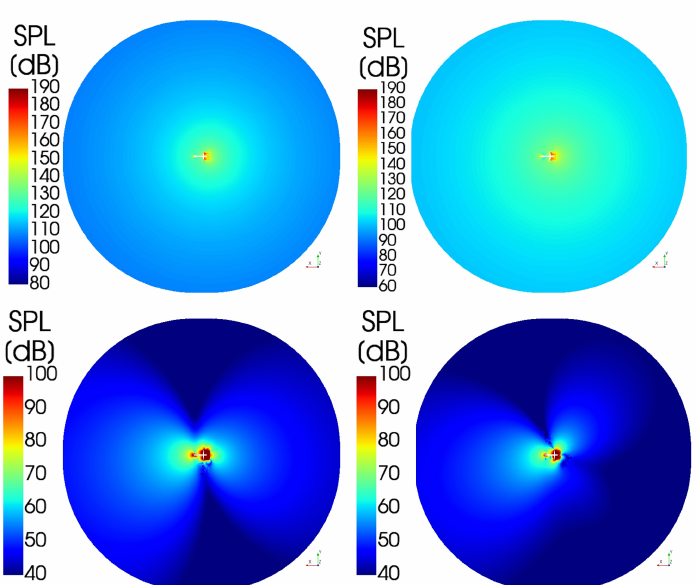
Figure 29. Sound pressure level contours in free field at 80 Hz ( top left ), 125 Hz ( top right ), 700 Hz ( bottom left ), and 1300 Hz ( bottom right ). Diameter of the free-field sphere is d = 3 m—VOF